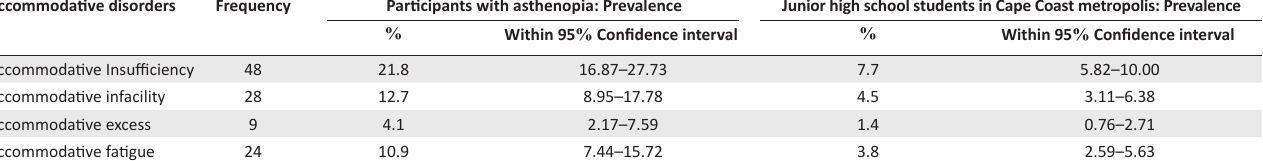
TABLE 2: Prevalence of specific accommodative disorders among